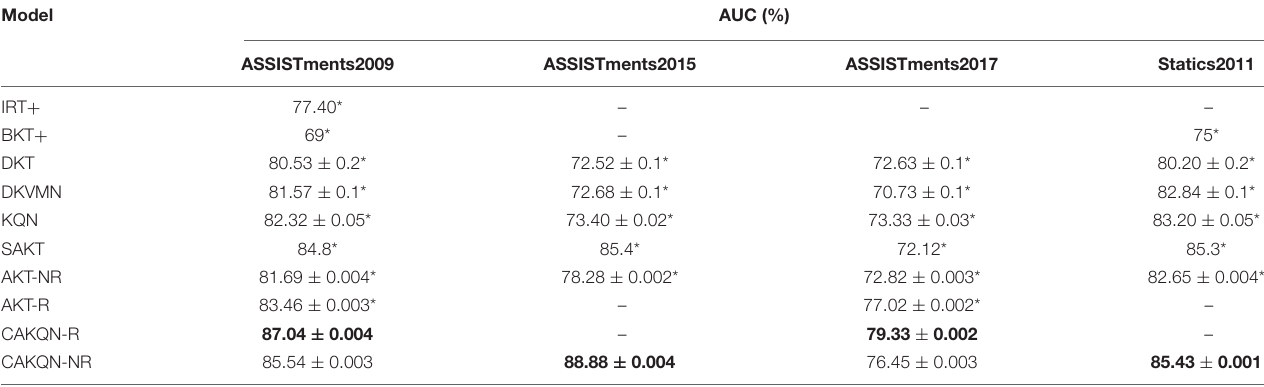
TABLE 2 | The predicted results of different methods on knowledge tracing.